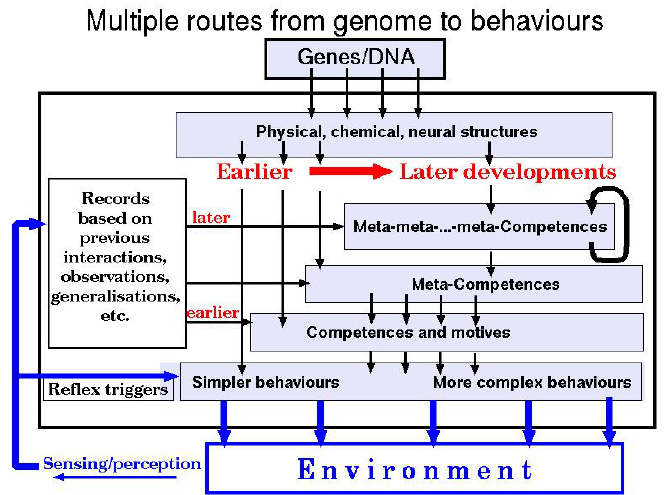
Figure 3. Staggered “waves of gene expression” in the Meta-Configured Genome. Genetically specified layers at the bottom begin development earliest. Processes further to the right occur later, building on records of earlier processes that help to instantiate more recently evolved genetic abstractions, expressed later in development. Many important motives are not reward-based but triggered by powerful internal reflexes produced by a combination of evolution and results of previous